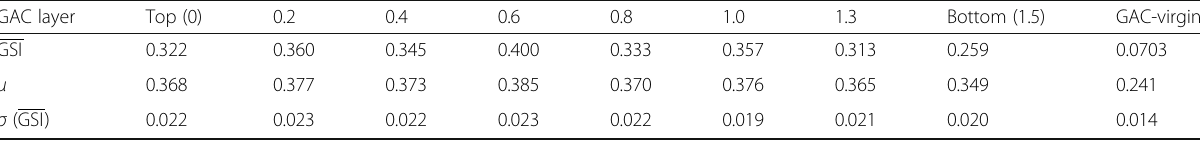
Table 3 Grey-scale intensity and linear absorption coefficient at different GAC layers and GAC-virgin (22 keV – 125